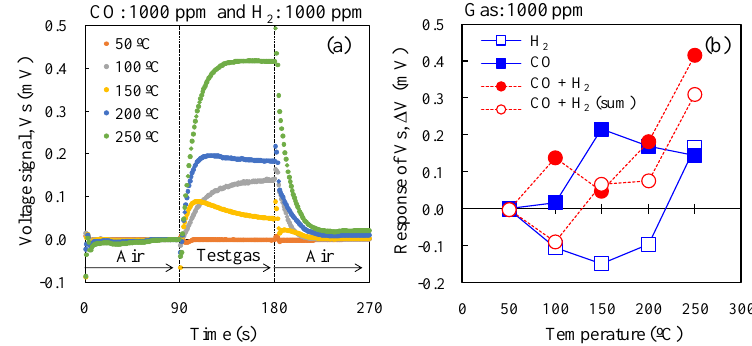
Figure 12. Vs of the double catalyst micro-TGS with AuPtPd/SnO 2 and 0.3 wt% Pt/α-Al 2 O 3 catalysts. ( a ) Response curves of the micro-TGS at catalyst temperatures of 25–300 °C for mixed gas (1000 ppm CO and 1000 ppm H 2 ) in dry air; ( b ) Catalyst temperature dependence of the ΔV of the micro-TGS for 1000 ppm CO, 1000 ppm H 2 , mixed gas (1000 ppm CO + 1000 ppm H 2 ), and calculated data (the sum of single gas data).